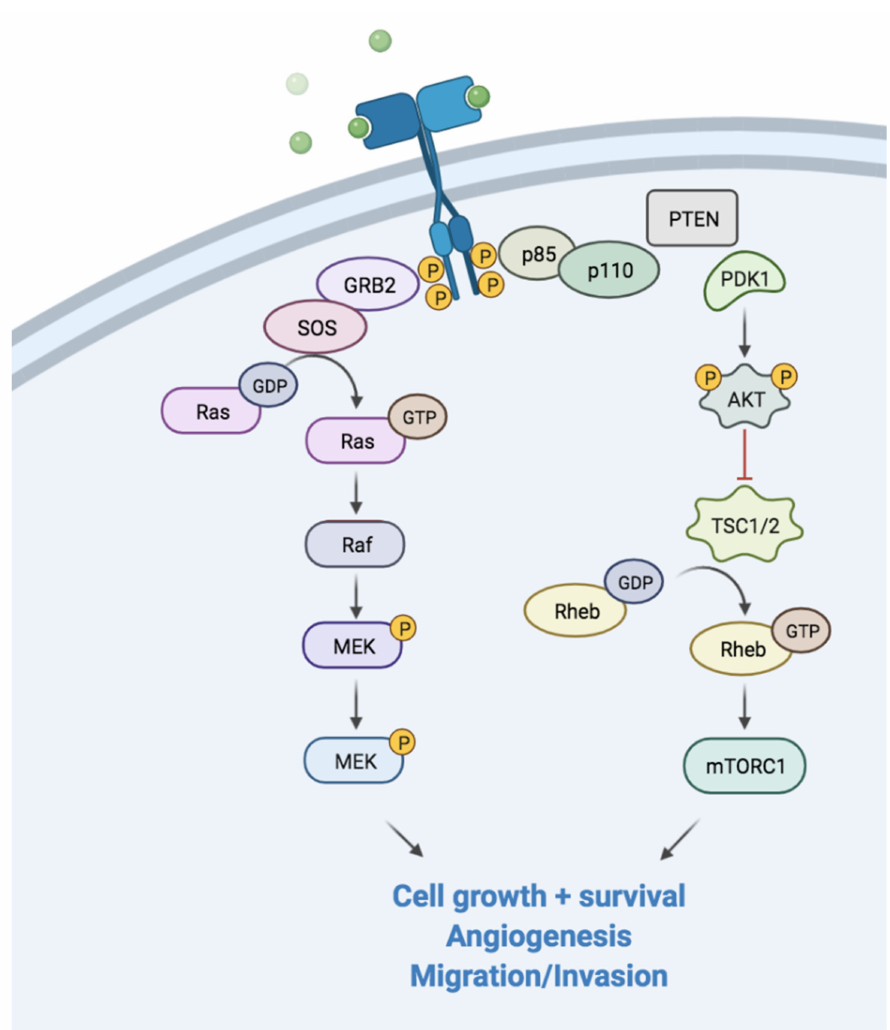
Figure 4. Schematic figure of the PI2K/Akt pathway. Following RTKs binding to the growth factors, the PI3K signaling pathway is activated. Akt: protein kinase B; GRB2: growth factor receptor-bound protein 2; PDK1: phosphoinositide-dependent kinase-1; PTEN: phosphatase and tensin